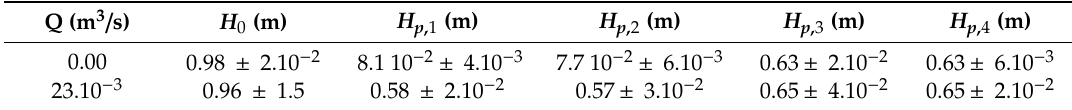
Table 1. The uncertainty related to measurements during tests.